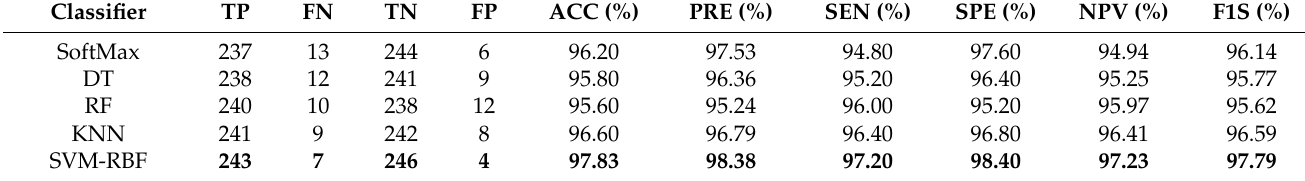
Figure 9. Spider plot to compare the CT image classification performance of CNN models.